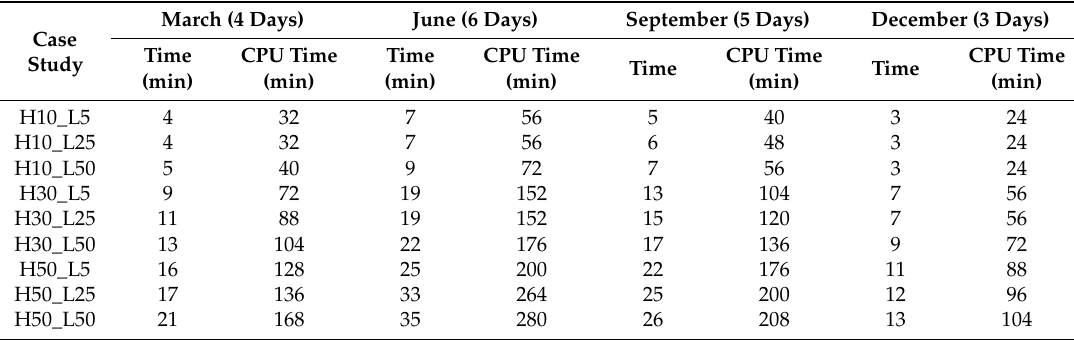
Table A1. Computation time in real and CPU time (minutes) for the simulations run for the 9 canyon configurations (orientation 0 ◦ ) for the 4 time periods (H = building height (m), L = street length